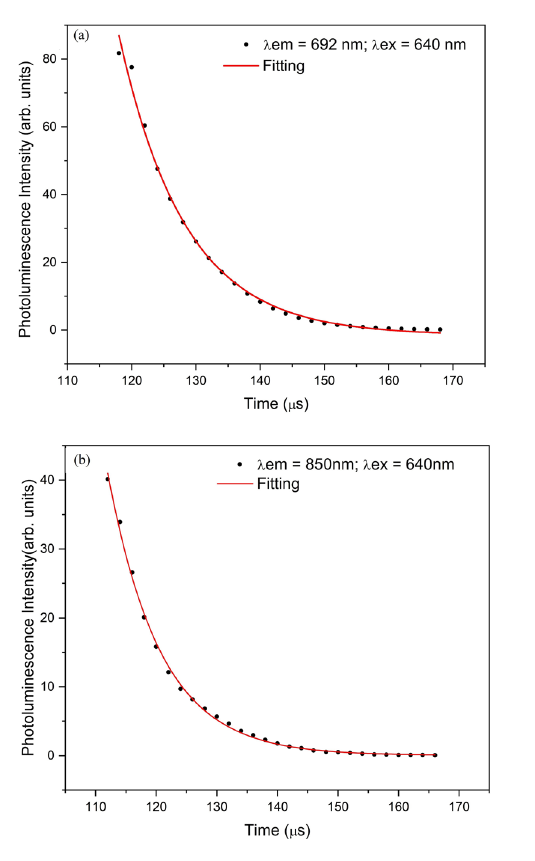
Figure 10. Room temperature photoluminescence decay measurements of the Zn SnO :Co 2+ (0.1%) monitored at (a)λ 2 4 λ =850 em